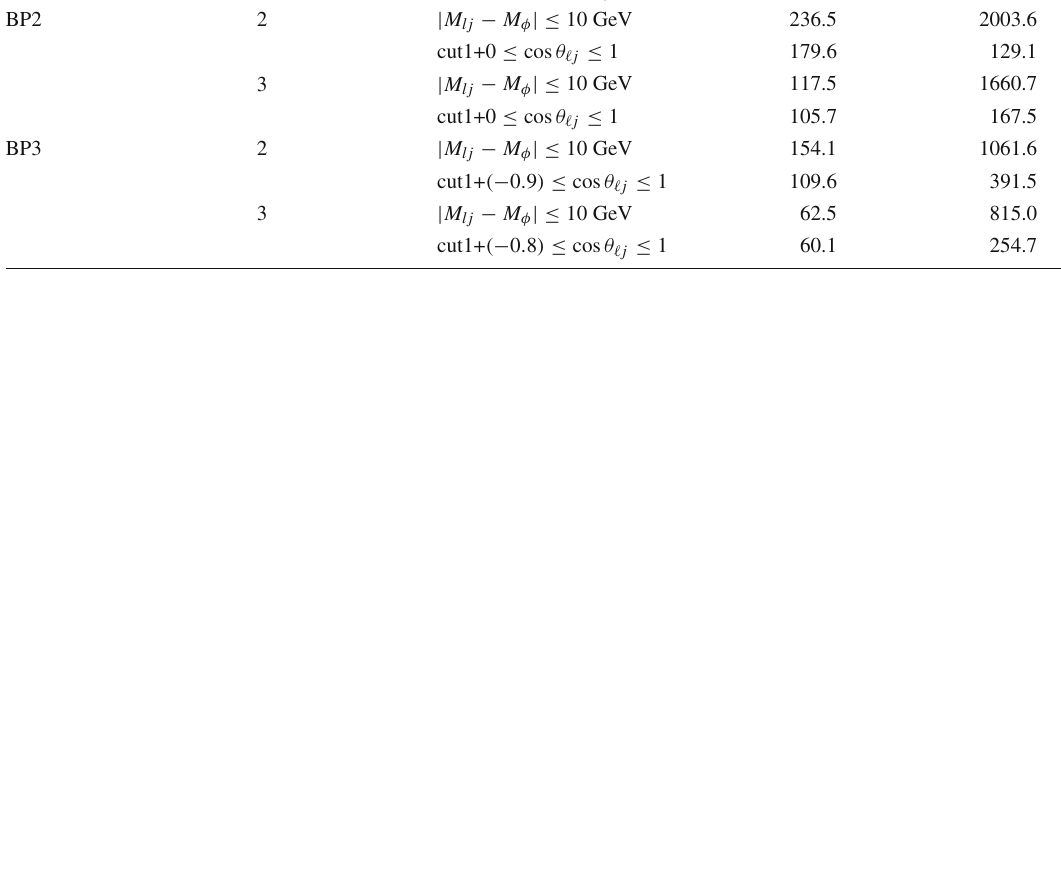
Table 12 Signal-background analysis for leptoquark ( (cid:19) V + 1 Bench-mark